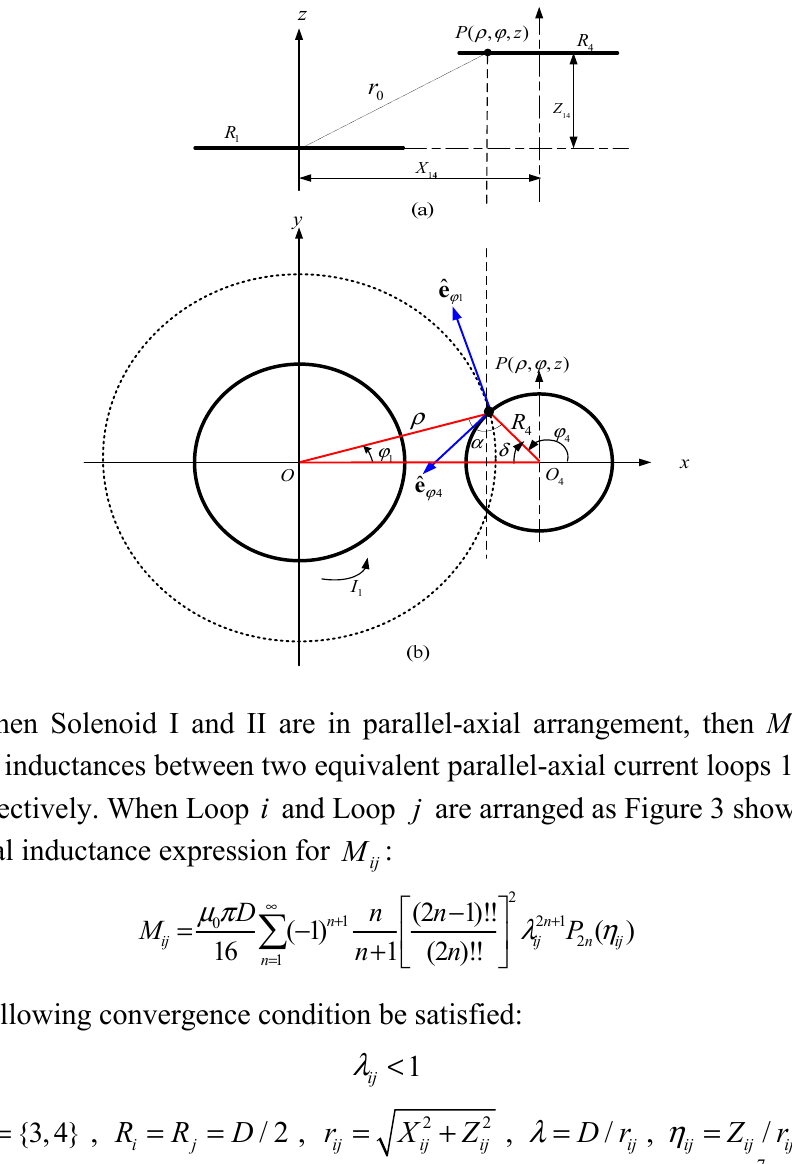
Figure 3. Geometric arrangement between equivalent parallel-axial Loop 2 and Loop